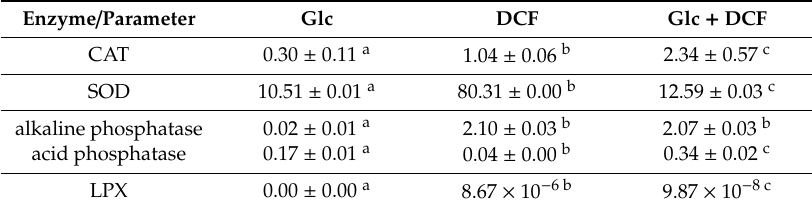
Table 2. The specific activity of CAT (U mg − 1 of protein), SOD (inhibition rate, %), LPX (MDA, nmol mg − 1 of protein), alkaline and acid phosphatases (Bessey’s units).